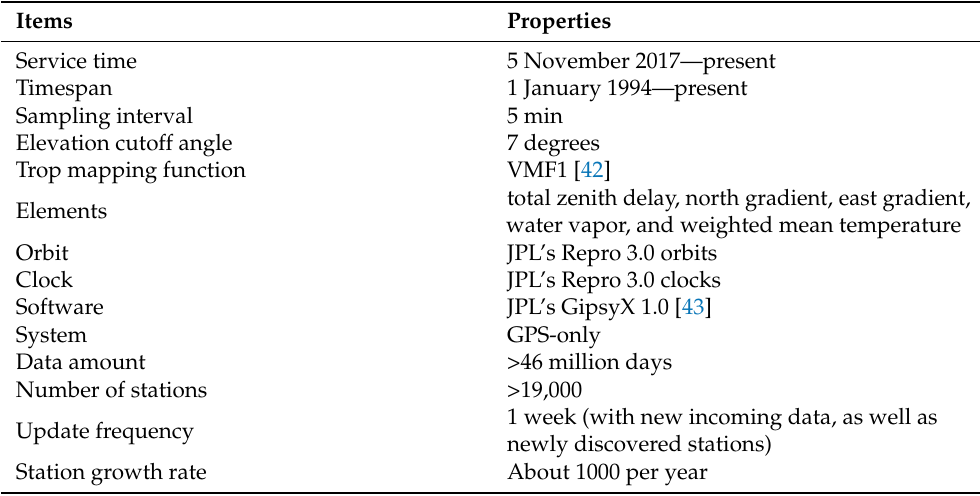
Table 1. Adopted models and strategies of Nevada Geodetic Laboratory